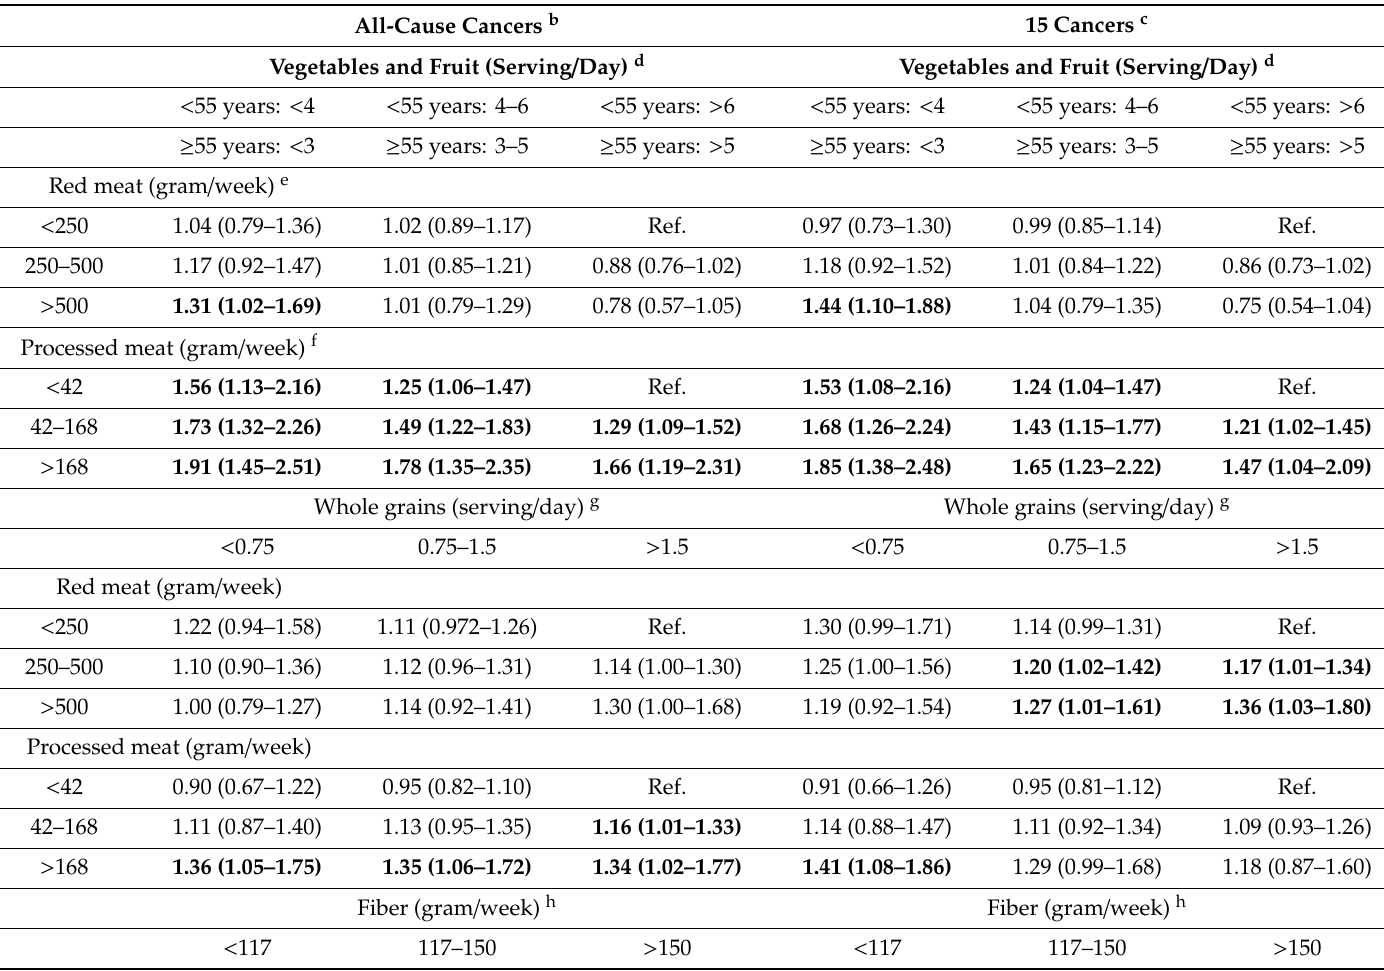
Table 2. Estimated hazard ratios a and confidence intervals for all-cause and 15 cancer incidence for di ff erent combinations of intake levels of red and processed meat with vegetables and fruit, whole grains, and fiber among men, Alberta’s Tomorrow Project ( n =